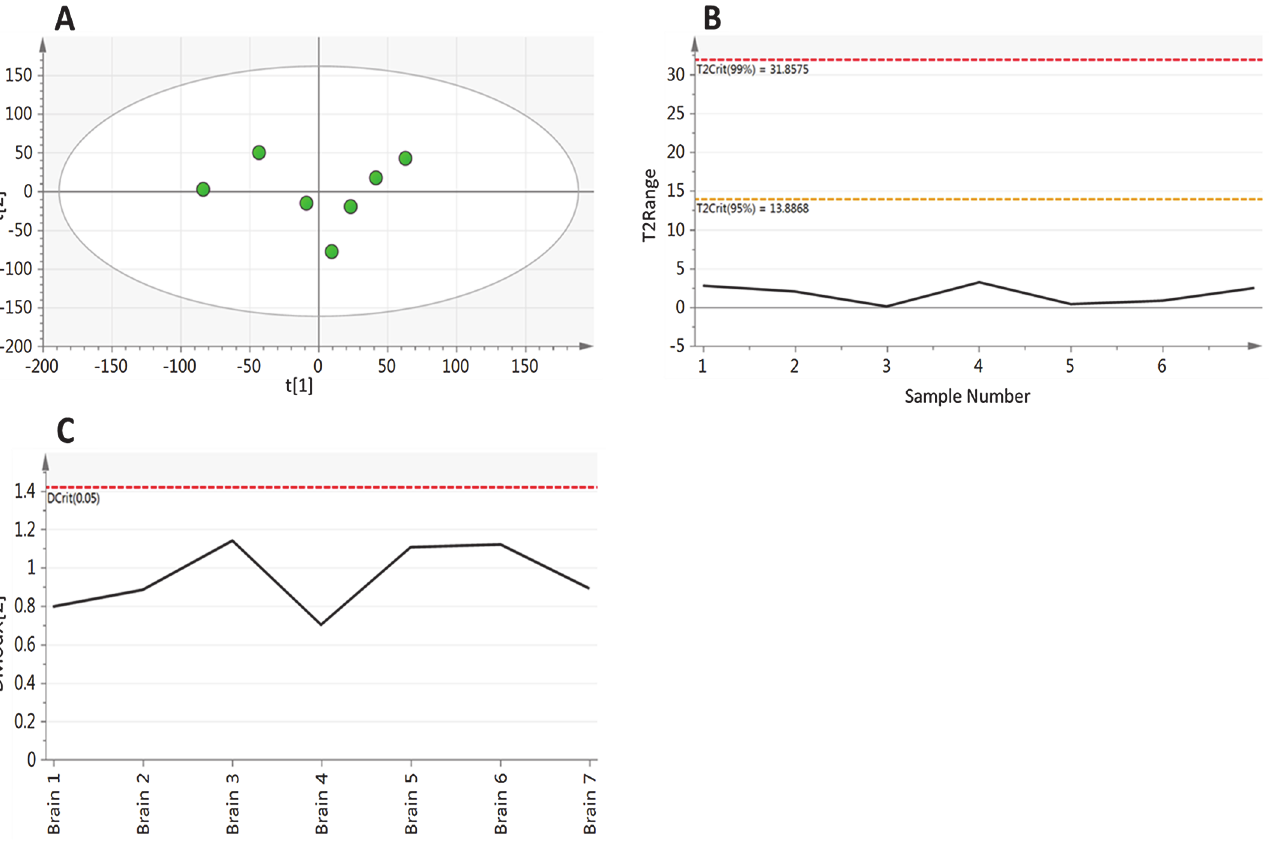
Fig 4. Principal component analysis (components = 2, R 2 X – 0.439, Q 2 – 0.210) of metabolite features identified in at least 70% of samples in experiment 1. A) scores plot and B) Hotelling ’ s T 2 and C) DModX plot, showing that sample mass has no effect on overall metabolite composition.